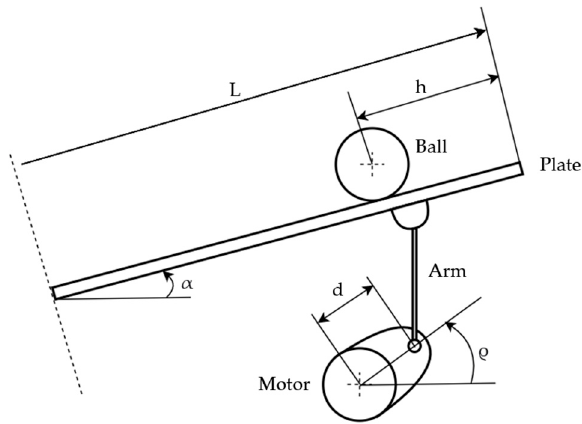
Figure 2. Kinematic diagram of a one-dimensional model.